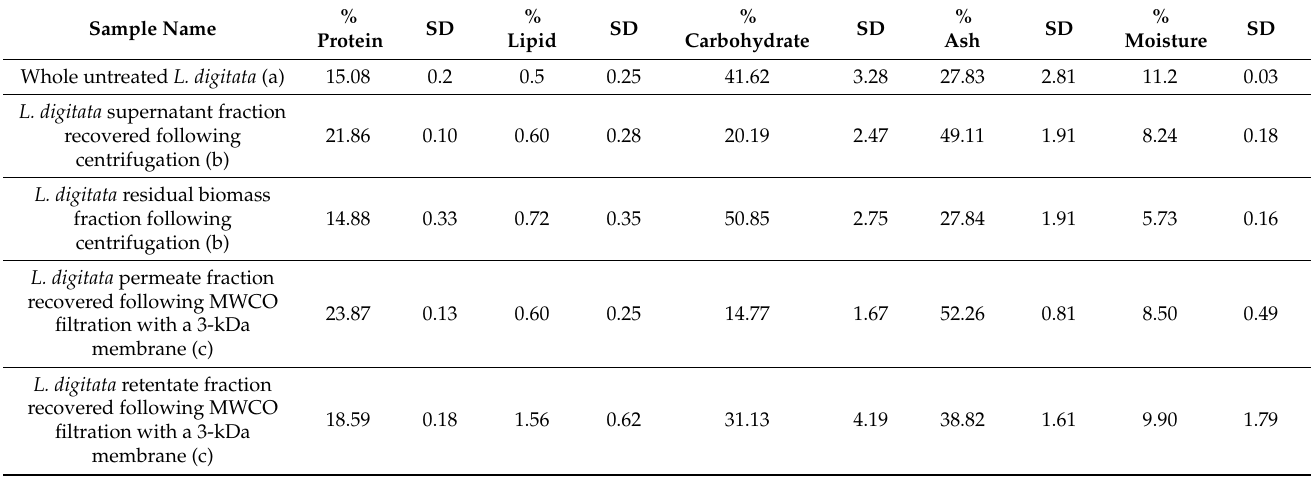
Table 1. Initial compositional analysis values for L. digitata whole biomass and fractions generated following enzyme treatment and centrifugation steps and subsequent 3-kDa MWCO filtration